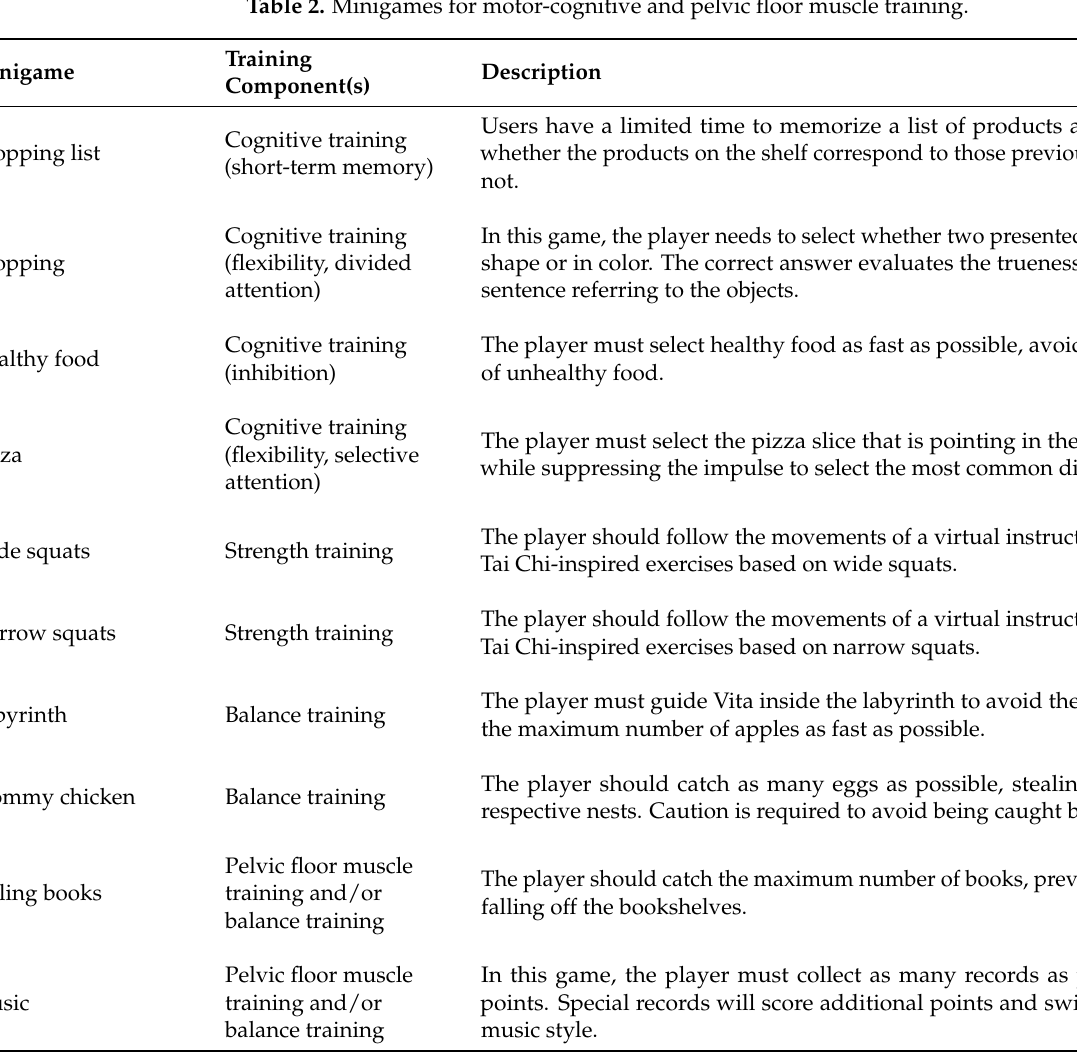
Table 2. Minigames for motor-cognitive and pelvic floor muscle